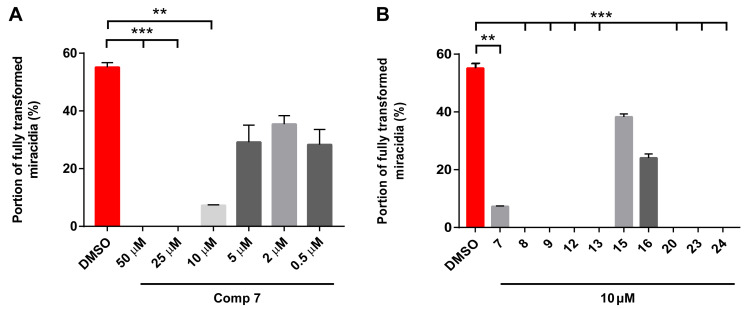
Compound 7 and its most active structural analogues block miracidia to primary sporocyst transformation.
Panel A - The effect of compound 7 (50, 25, 10, 5, 2 and 0.5 μM) on miracidia transformation was registered in terms of % fully transformed sporocysts enumerated after 48 h. Each treatment was set up in triplicate and parasites were cultured in CBSS with 1% DMSO at a controlled temperature of 26°C (in the dark).
Panel B - A drug screen was performed to assess the effect of compound 7 analogues at 10 μM to block miracidial transformation compared to the lead compound and DMSO (negative control). Statistical analysis was performed similarly to
Figure 4. **, *** represent
p < 0.0055,
p < 0.0003, respectively.